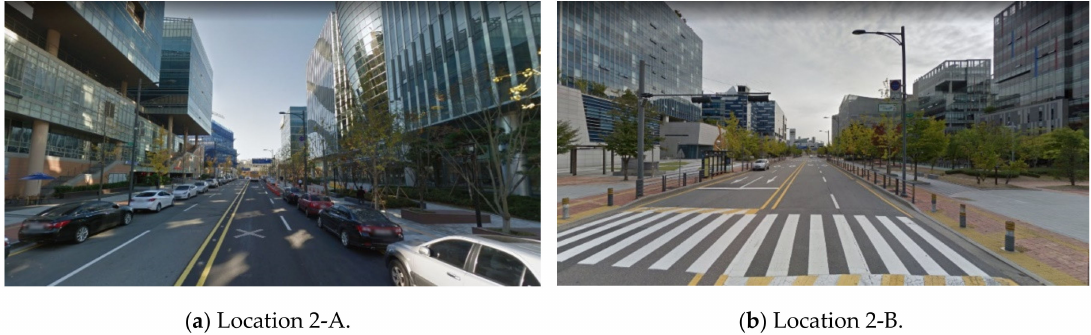
Figure 14. VPD di ff erence according to the building layout (Naver Maps [33]).